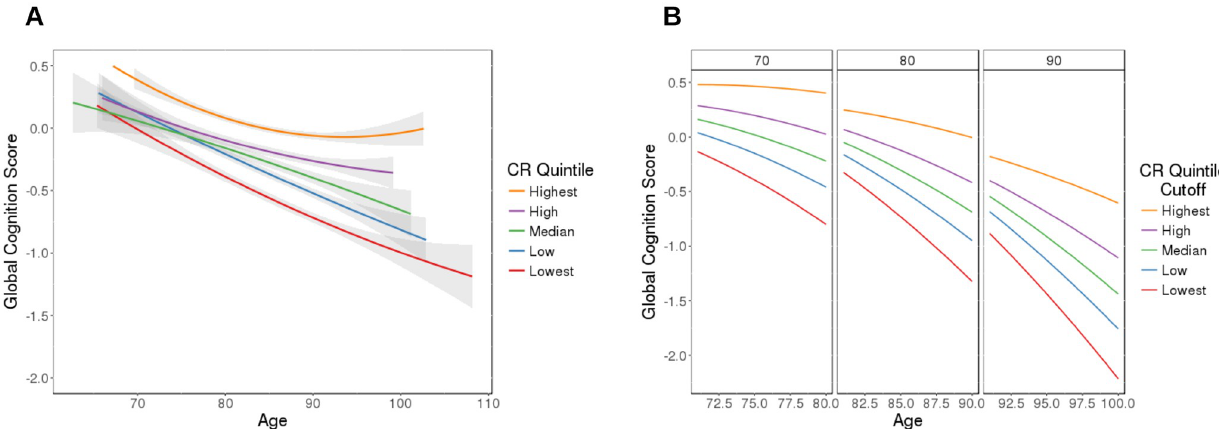
Fig 3. Global cognition (vertical axis) is shown over time (age, horizontal axis). (A) Longitudinal global cognition trajectories grouped by AD-CR Score quintile group. For each of the quintile groups a smoothed curve with 95% confidence band is shown. (B) The predicted longitudinal cognition trajectories for the AD-CR Score quintile groups from the fitted mixed effects model. The plot is divided into three panels, one panel each for baseline age of 70, 80, and 90 with 10 years of predictions for each of the panels.